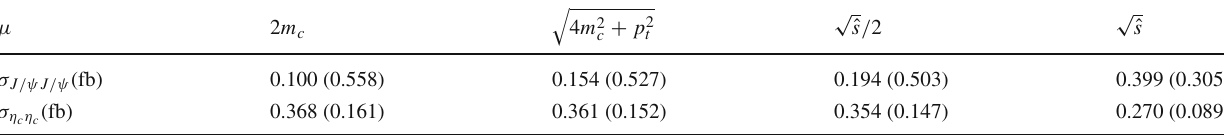
Table 1 The LO (in brackets) and NLO total cross sections for J /ψ -pair and η c -pair productions via photon–photon fusion at the SuperKEKB collider. Here, the transverse momentum cut p t ≥ 0 . 01GeV is imposed on every single